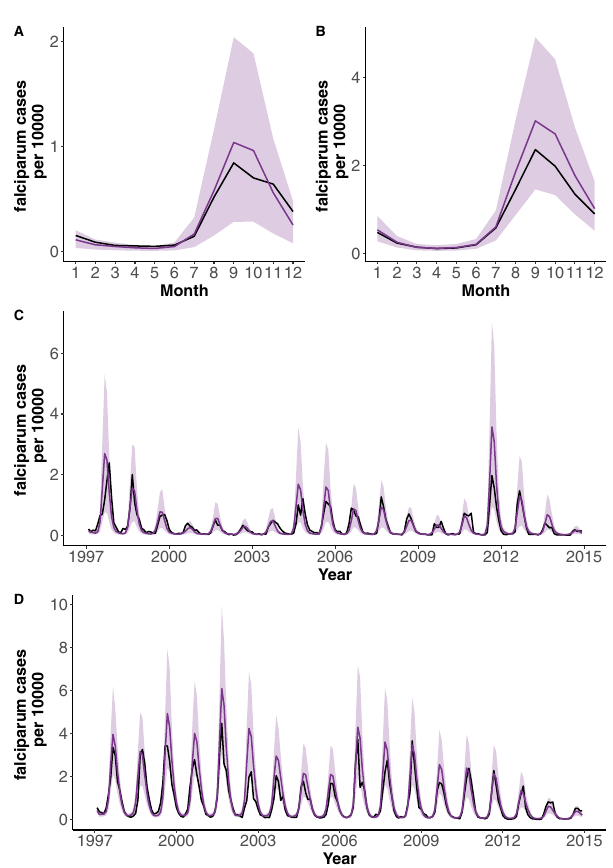
Fig. 2 Comparison of observed and simulated monthly cases with the best model for both cities. Time series and seasonality for the observed cases (black) and the mean of 1000 model simulations (purple) for the two cities. The intervals between the 10% and 90% percentiles of the simulated data are shaded in light purple. Seasonality is shown in ( A ) for Ahmedabad and in ( B ) for Surat; the monthly time series are shown in ( C ) for Ahmedabad and in ( D ) for Surat. The simulated cases are not next step predictions but the predicted values from forwarding simulations of the model for the whole 20 years ’ study period starting with estimated initial conditions. The estimation framework considers both types of noise: process noise to account for “ environmental ” stochasticity in the transmission process and observational noise as encoded in a measurement